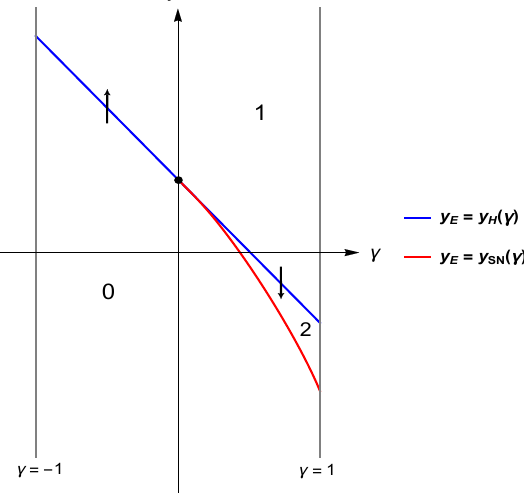
Fig. 4 Bifurcation set in the parameter plane ( γ , y E ) for x E < − 1. We emphasized the number of symmetric periodic orbits in each